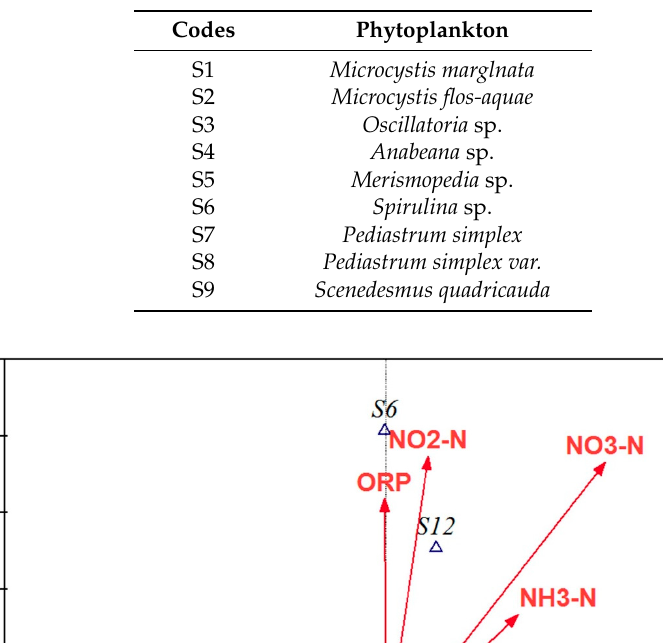
Table 2. Codes of phytoplankton species used in canonical correspondence analysis CCA.